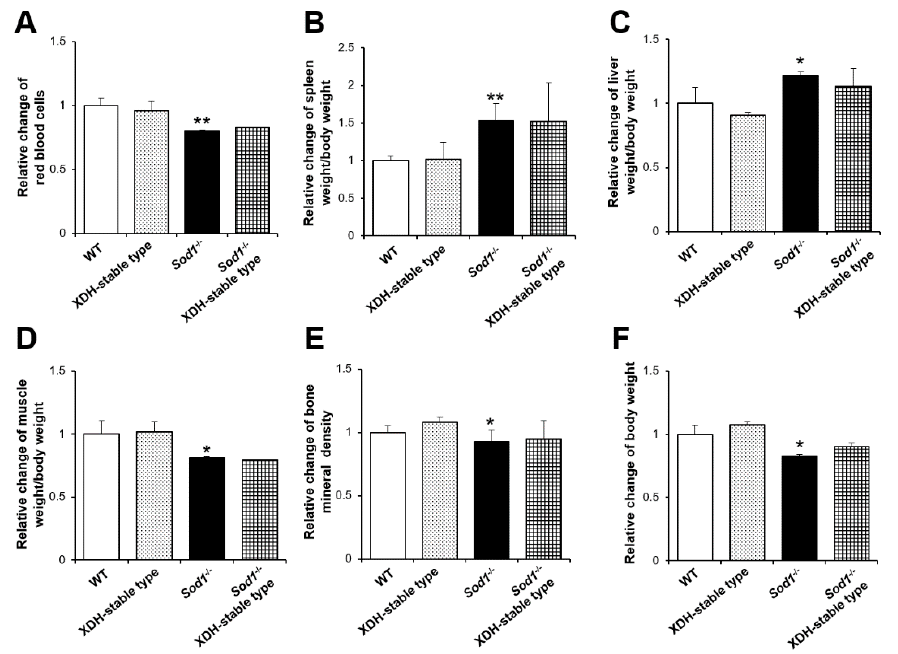
Figure 2. A phenotypical analysis of Sod1 , XDH-stable-type double-mutant mice. Relative changes in the red blood cell count ( A ), spleen weight ( B ), ratio of spleen weight/body weight ( C ), ratio of muscle weight/body weight ( D ), bone mineral density ( E ), and body weight ( F ) of WT, Sod1 − / − , XDH-stable, and Sod1 − / − XDH-stable male mice (4–5 months of age, n = 3). * p < 0.05, ** p < 0.01. Data are shown as the mean ±